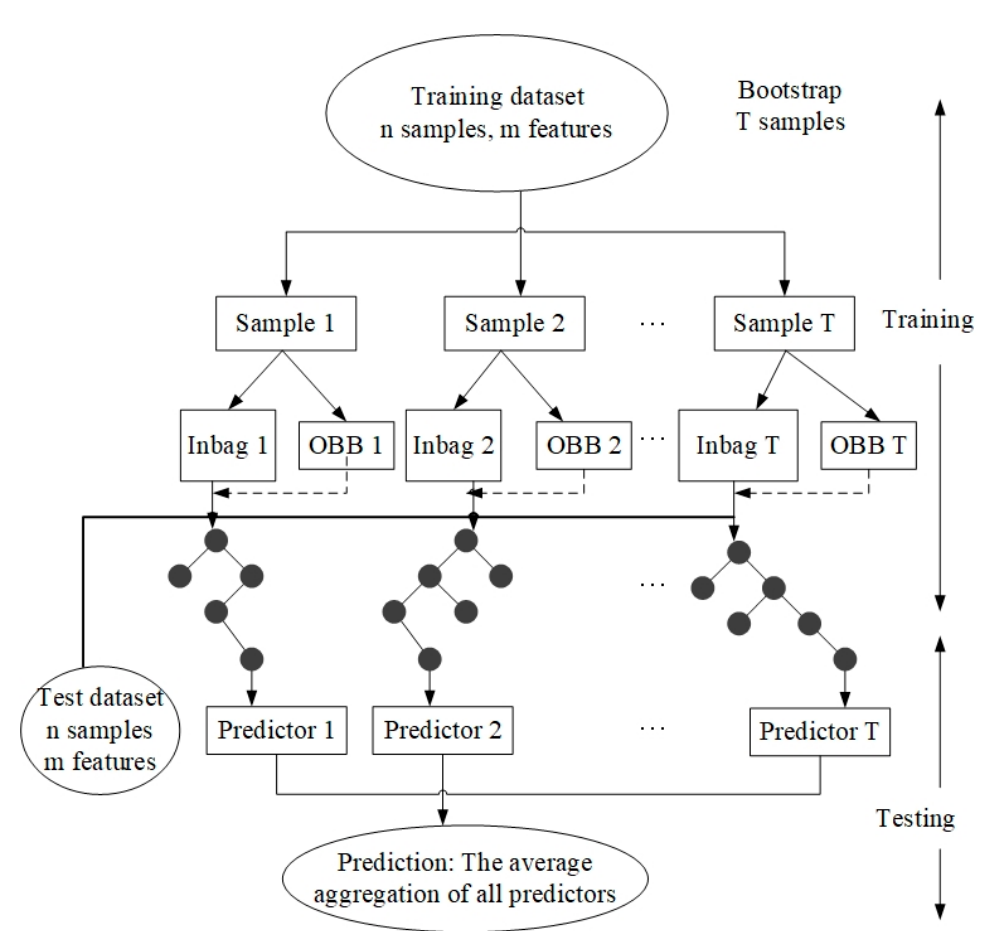
Figure 2. Structure of the random forest (RF) method. OBB is out-of-bag data.